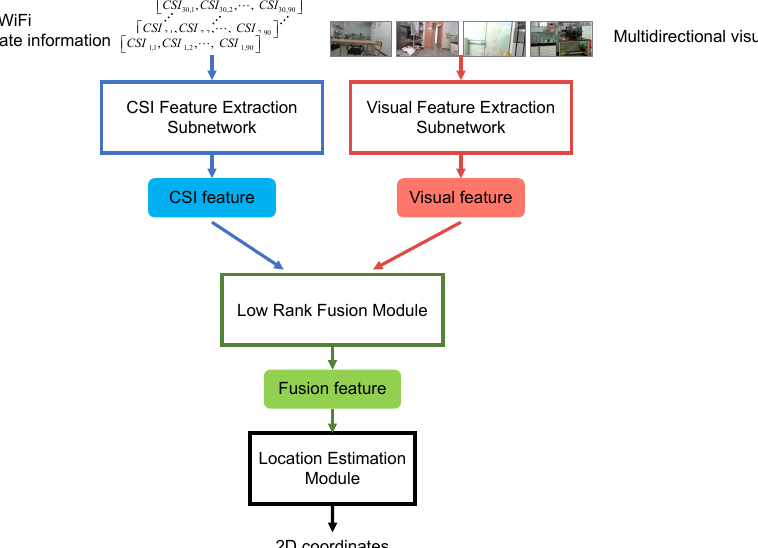
Figure 2. The framework of LRF-WiVi. After offline training, the model can predict the position of the input data in the online